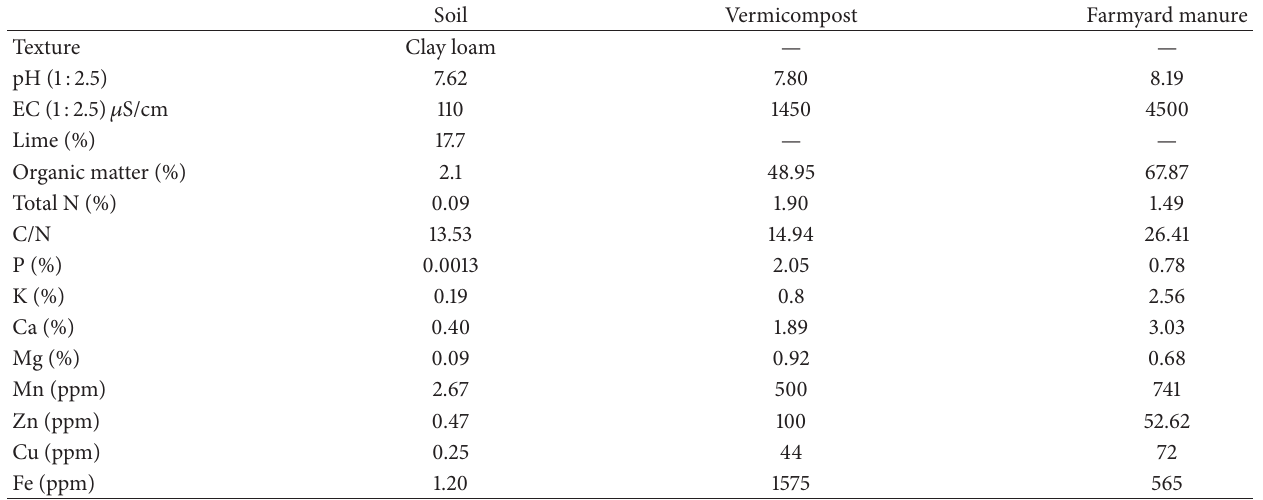
Table 1: Physical and chemical properties of soil and organic materials used in the study. Soil Vermicompost Farmyard